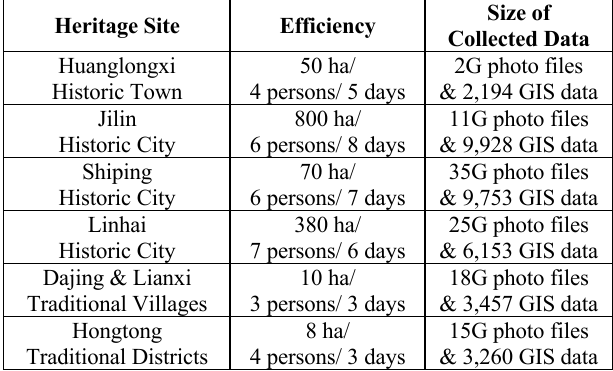
Table 2. The Efficiency and The Size of Collected Data in Six Heritage